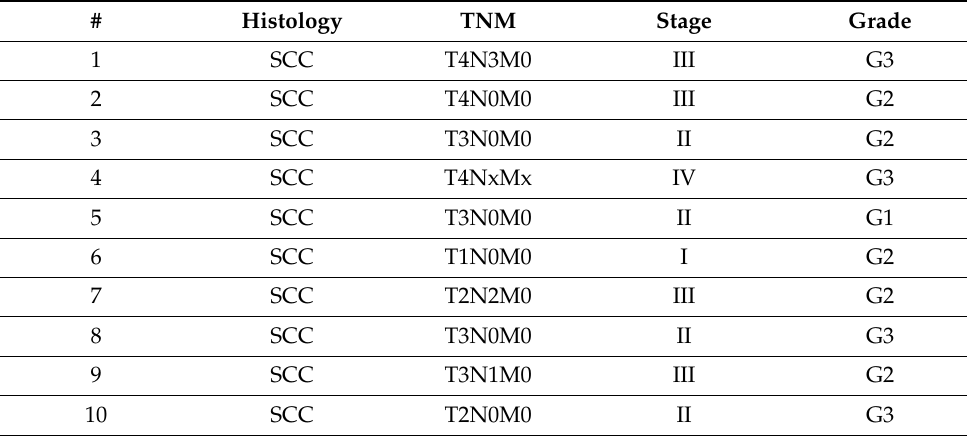
Table 2. Clinicomorphololgic characteristics of samples used for